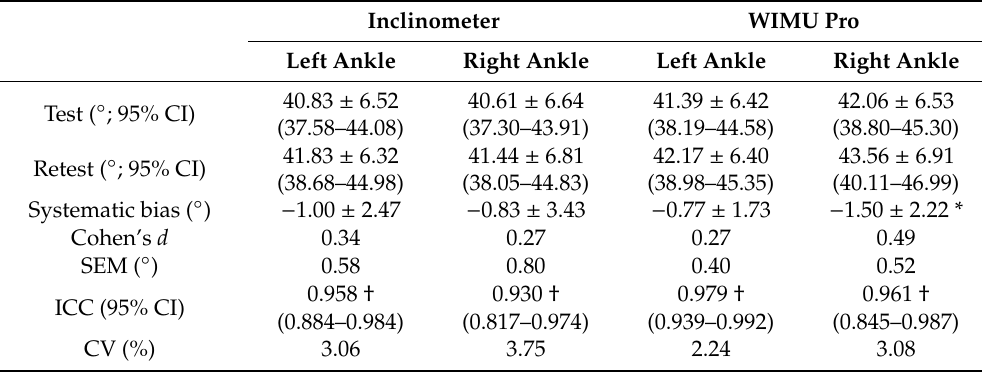
Figure 4. Correlation between right ankle dorsiflexion (degrees) measured by the inclinometer and WIMU Pro. Table 2. Test-retest reliability analysis for measuring ankle dorsiflexion.